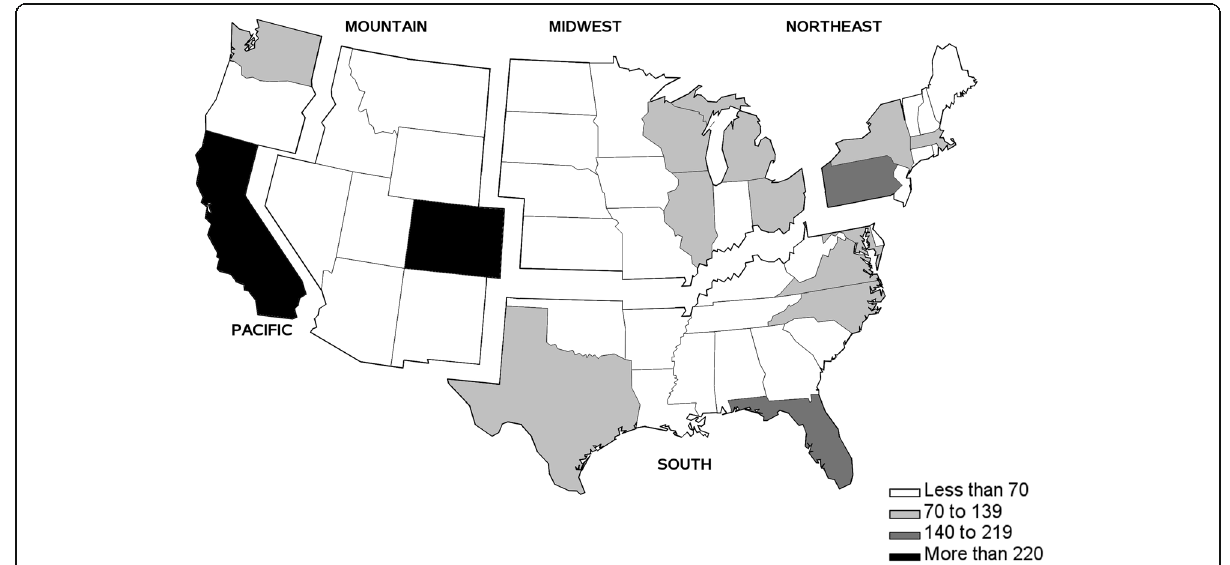
Fig. 1 Recruitment regions and number of dogs enrolled by state in the Golden Retriever Lifetime